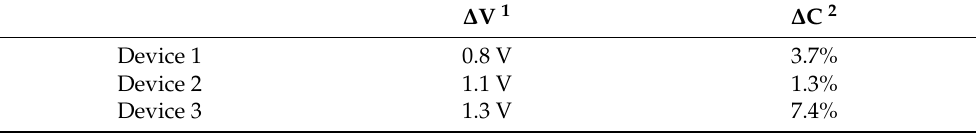
Figure 3. C-V characteristics of blue TADF OLEDs before and after degradation: ( a ) device 1, ( b ) device 2, and ( c ) device 3. Table 3. Peak voltage and peak capacitance shift values after degradation of devices 1, 2, and 3.